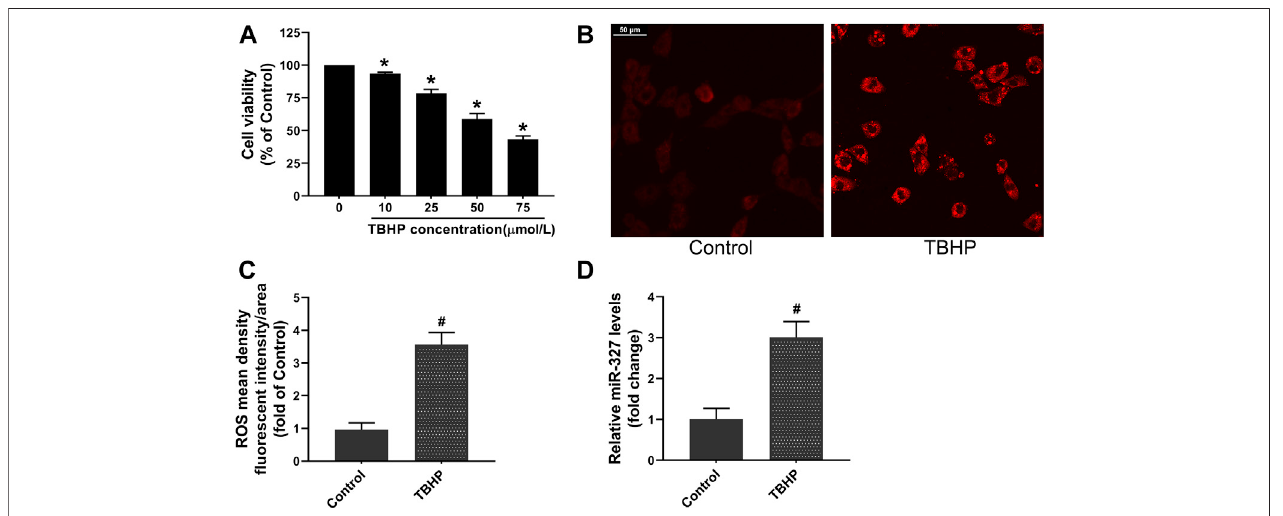
FIGURE4| TBHP inducedoxidativedamageandpromotedmiR-327expression inH9c2cells. (A) CellviabilitywithdifferentconcentrationsofTBHP.Theeffectof 50 μ M TBHP on intracellular ROS production in H9C2 cells, images were obtained by confocal laser microscopy (B) and analyzed by Image-Pro Plus (C) . (D) Relative expression of miR-327 in cells tested by qRT-PCR. Data are expressed as the mean ± SD; n (cid:2) 3; * p < 0.05 versus the normal group; # p < 0.05 compared to the Control group.